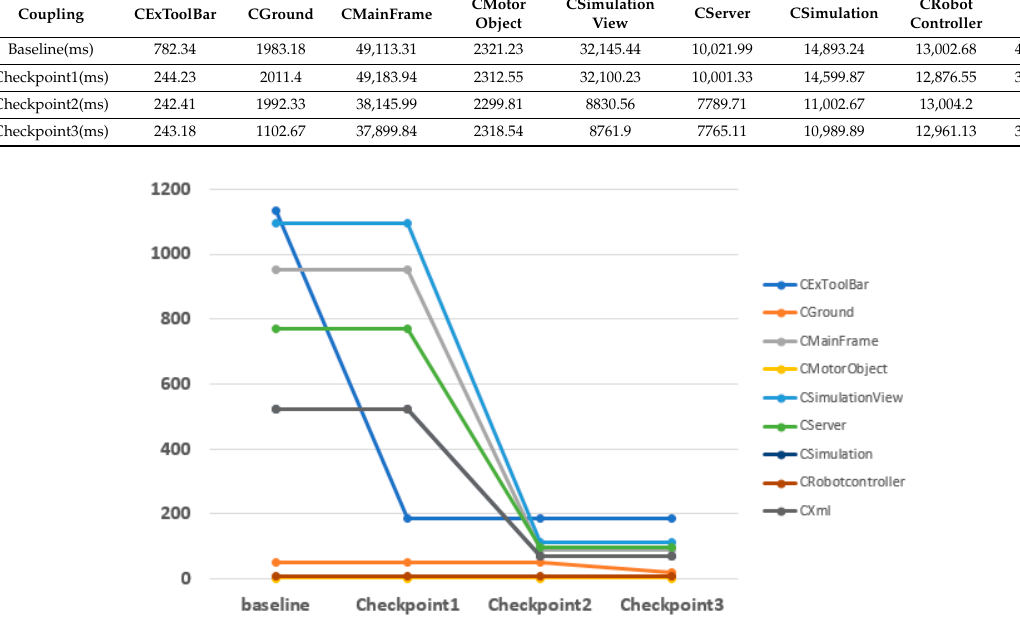
Figure 8. Results of performance measurement.